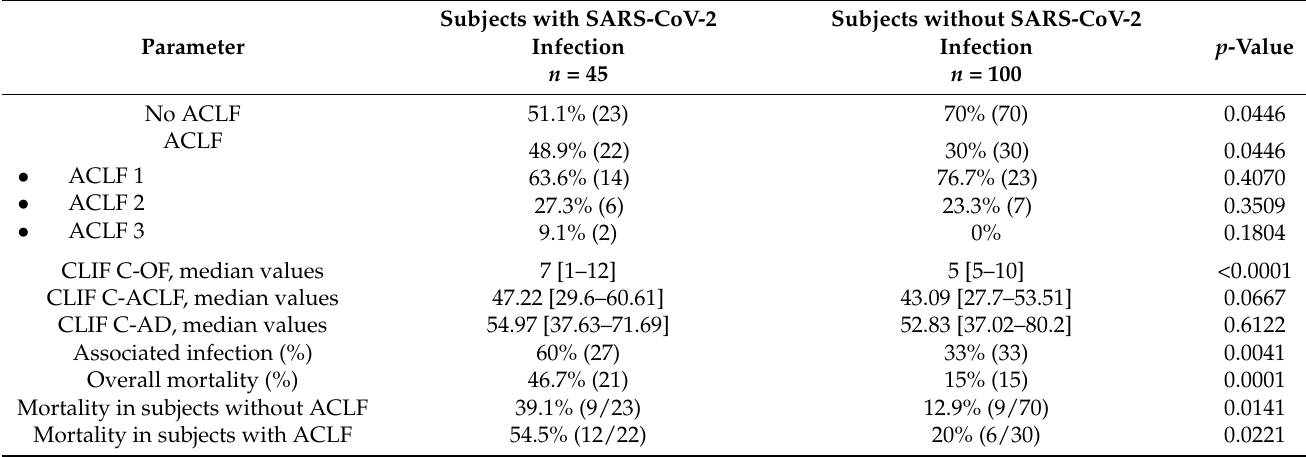
Table 3. Decompensation events and specific mortality.